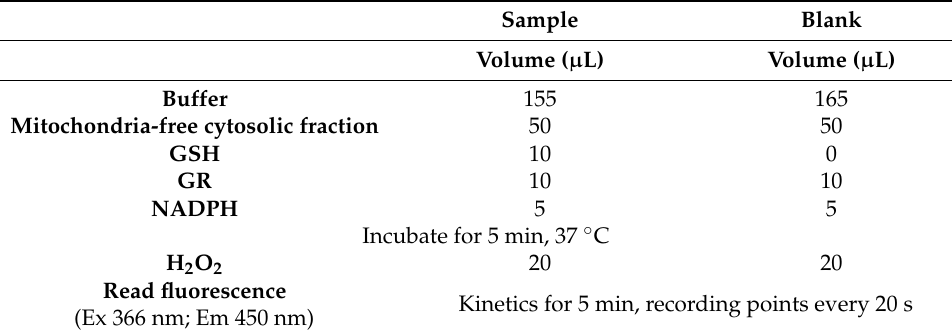
Figure 5. GPx activity is evaluated by a coupled reaction with GR enzyme. GPx reduces hydrogen peroxide to water and oxidizes GSH to GSSG. The generated GSSG is reduced to GSH with NADPH consumption by GR. Table 3. Conditions and flow setup for GPx activity assay.